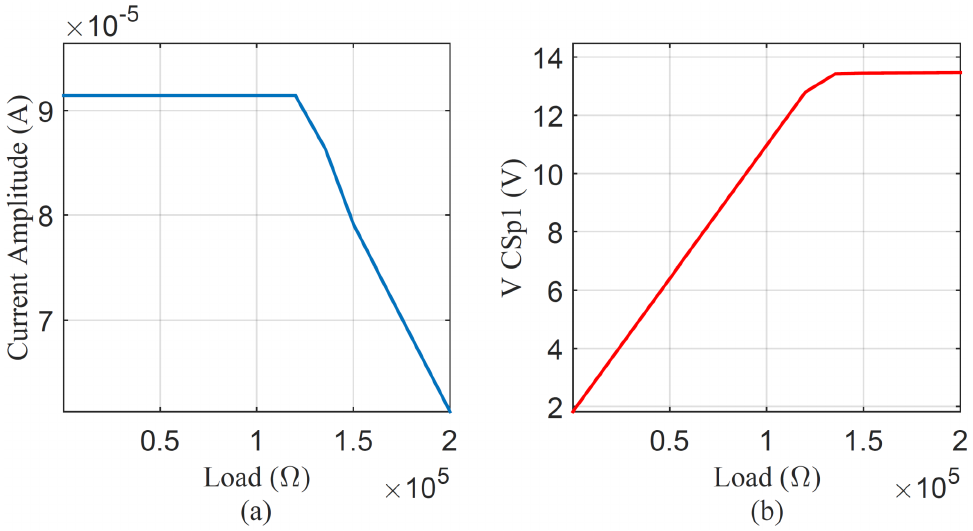
Figure 6. Output current sensitivity to load impedance changes: ( a ) from 0 to 120 k Ω the current remains fixed at 91.42 µ A, a higher impedance value falls out of the fixed current range; ( b ) the voltage in CSp 1 yields to voltage saturation of the TL084 op-amp when the load is higher than 120 k Ω